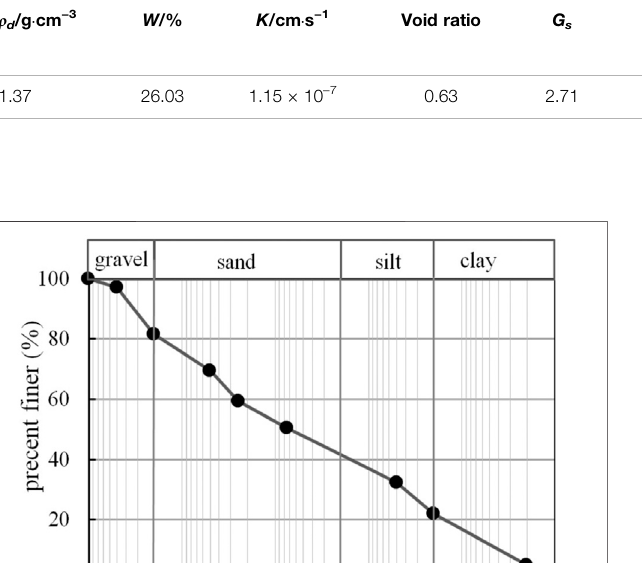
TABLE 1 | Physical and mineralogic properties of GRS.